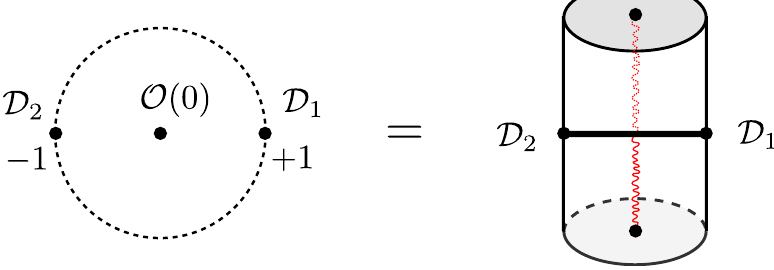
Figure 30 . The symmetric con(cid:12)guration and the AdS picture. For the symmetric con(cid:12)guration, the string worldsheet (drawn in the global AdS) is cut into halves by the geodesics of the Giant